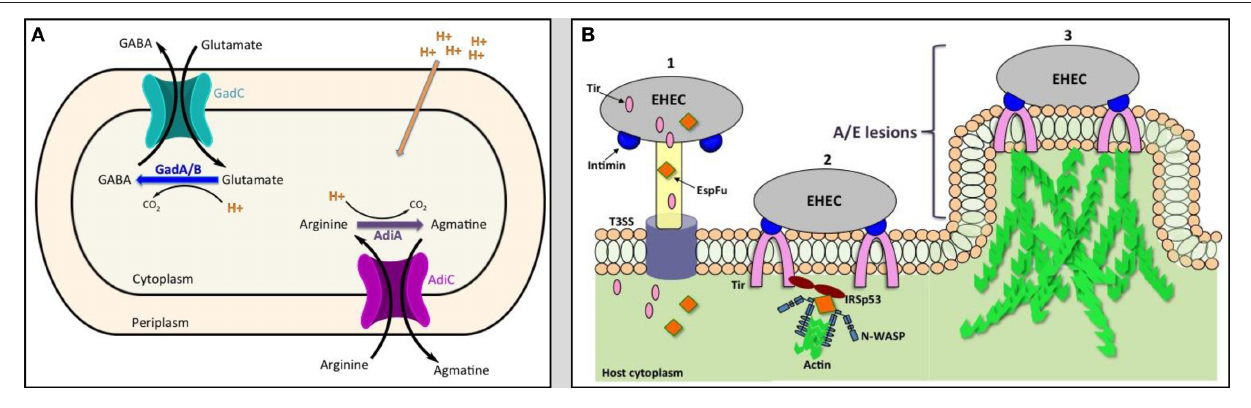
FIGURE 1 | The model of acid resistance system 2 and 3 (A) and the schematic diagram of the formation of attaching and effacing (A/E) lesions (B). EHEC injects effector proteins such as Tir and EspFu into the host